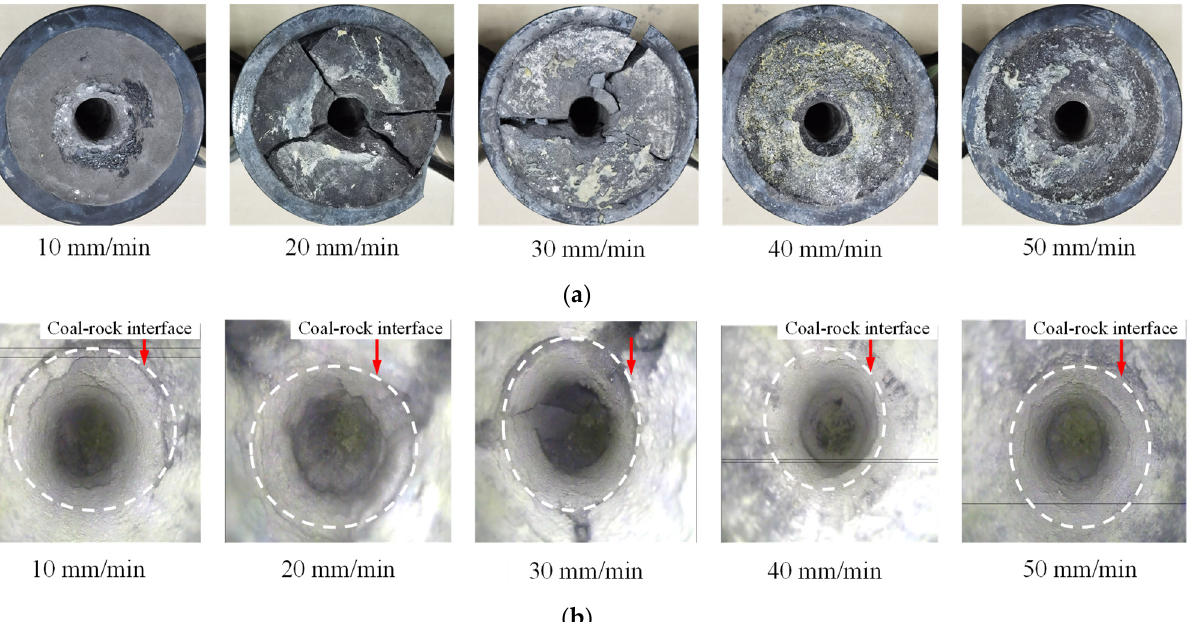
Figure 10. Failure characteristics of the coal–rock composite anchor after pull-out: ( a ) external damage characteristics; ( b ) damage characteristics of internal borehole.